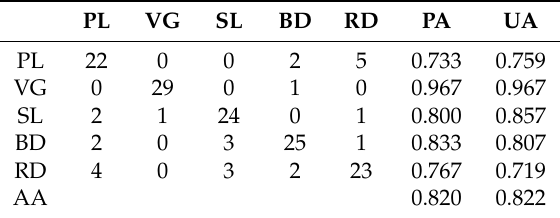
Table 12. Confusion matrix of the CL-DT in the third area.